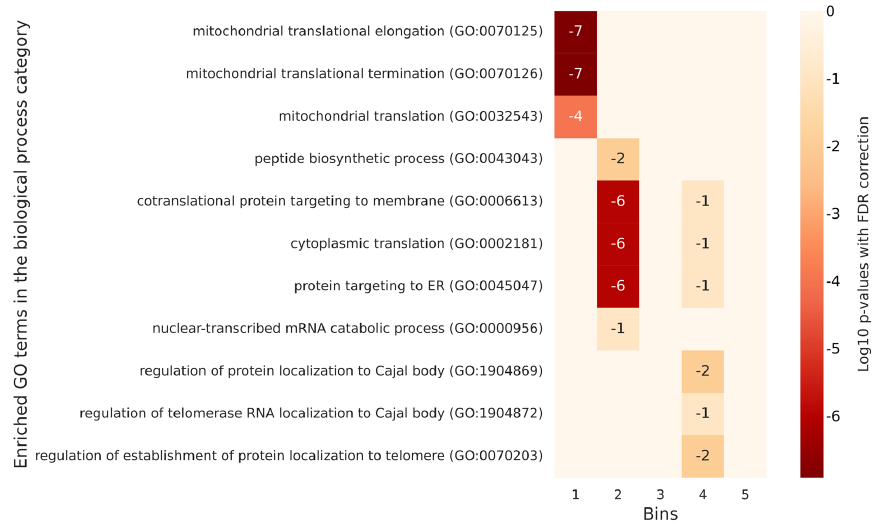
Figure 7. A heatmap of selected GO enrichments identified for D. melanogaster proteins grouped according to their number of phosphorylation sites. The figure lists the significant GO enrichments by biological process terms for each bin of D. melanogaster proteins defined according to their degree of phosphorylation. Each table row represents a different GO term, and each column represents a different bin. The numbers in the cells are the log10 p -values with FDR correction of the enrichment of a bin with a specific GO term. Empty cells are associated with a log10 p -value of 0, which corresponds to a p -value of 1. In the flies, the less phosphorylated proteins (those in the first two bins) have a role in protein formation and transport. Few annotations are associated with the most phosphorylated proteins.